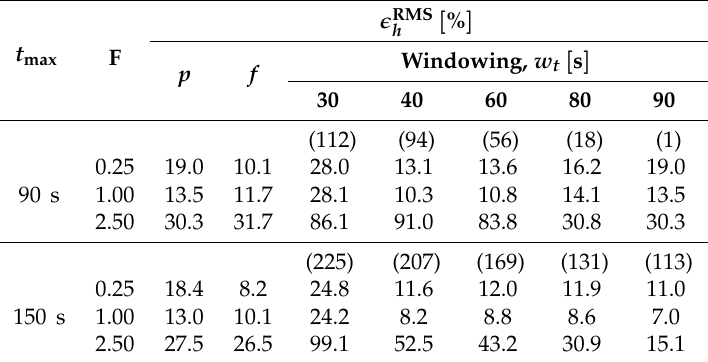
Table 9. Results for the first mode for nonlinear wave propagation of the polychromatic WS case with different F factors, total video length t max , and window width w t : Relative RMSE, (cid:101) RMS h (cid:62) 0.75 m. Here, “ p ” and “ f ” stand for results using phase and function fitting for t max , respectively.